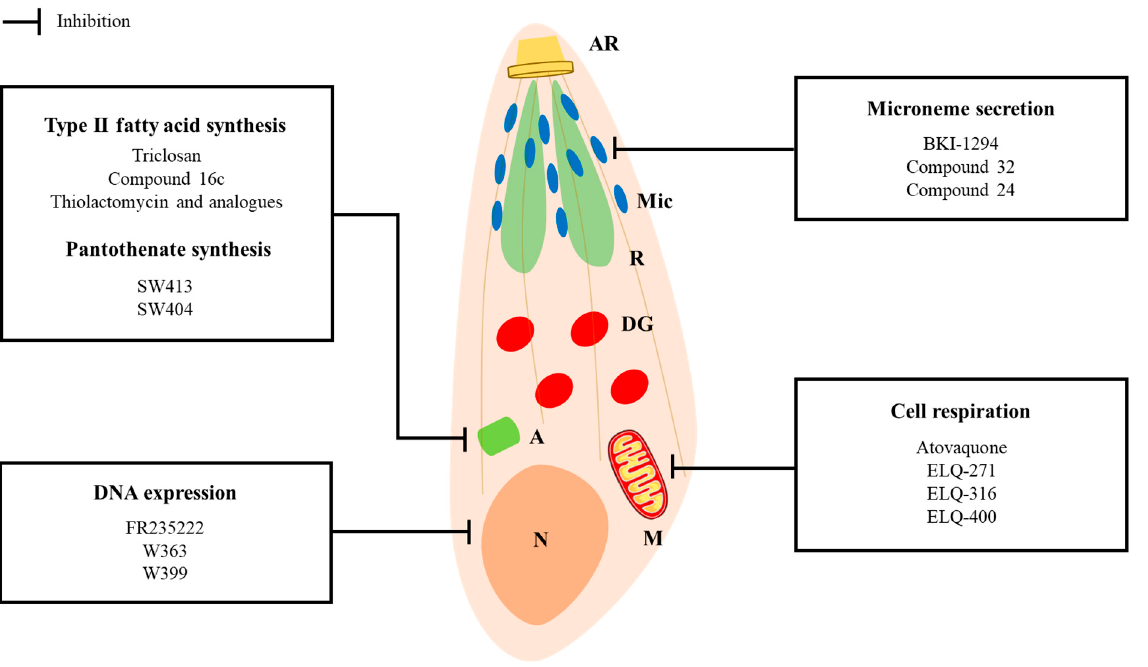
Figure 1. Graphical representation of a Toxoplasma gondii tachyzoite. Organelle and pathway targets of several experimental and repurposed compounds [43–56]. AR: apical ring; Mic: microneme; R: rhoptry; DG: dense granule; A: apicoplast; M: mitochondrion, N: nucleus; BKI: bumped-kinase inhibitor; ELQ: endochin-like quinolone.